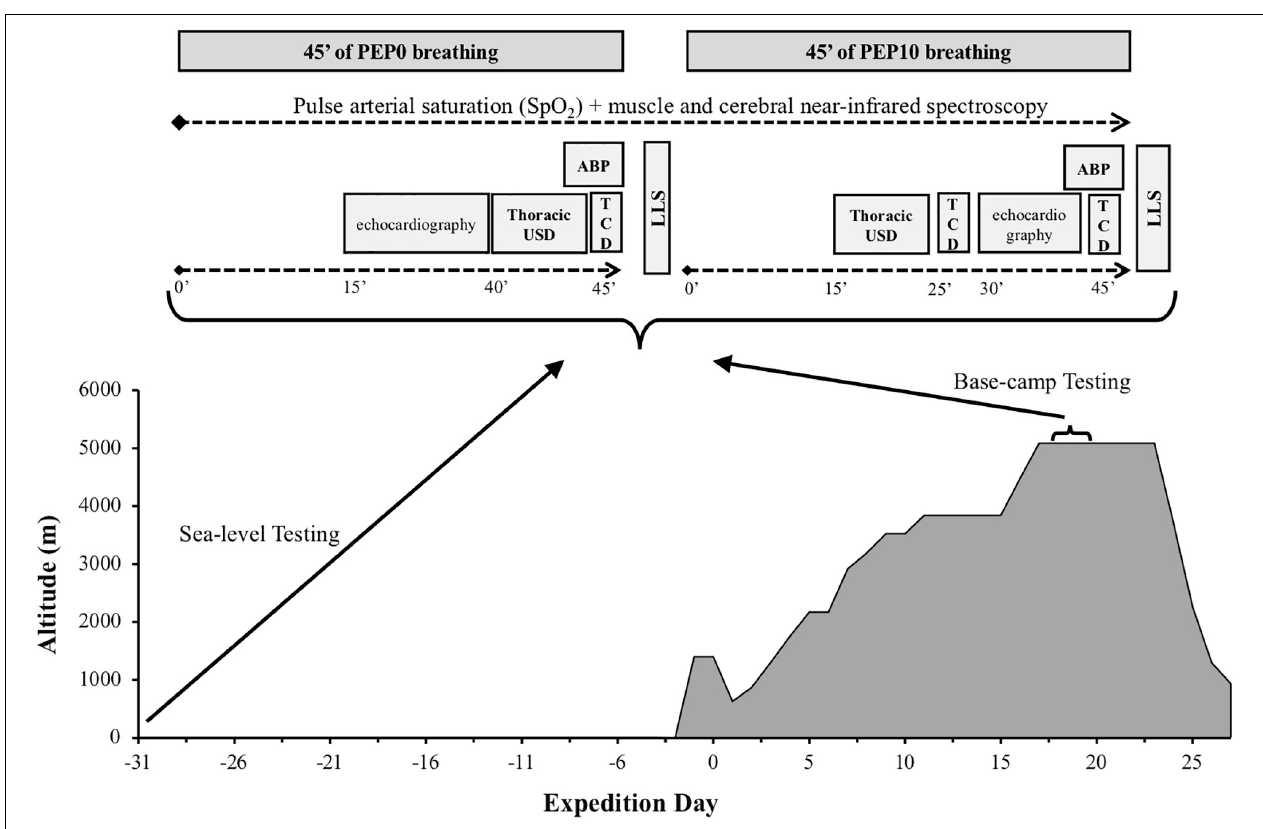
FIGURE 1 | Schematic view of the experimental design and measurements performed at different time points at sea level and high altitude base camp. ABP, systolic-diastolic and mean arterial blood pressure; LLS, Lake Louise Score; TCD, transcranial ultrasound doppler; USD,